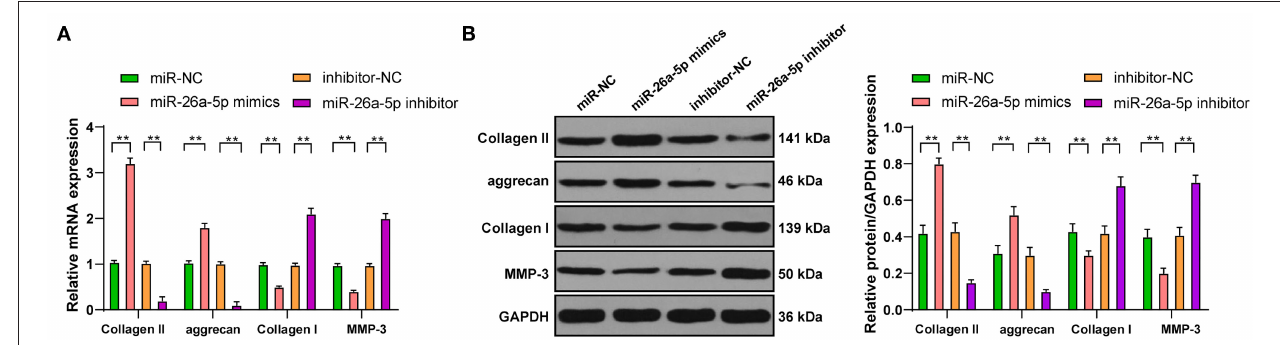
FIGURE 4 | Overexpression of miR-26a-5p can promote ECM synthesis in degenerative NPCs. In degenerative NPCs transfected with miR-26a-5p mimic/inhibitor, the mRNA, and protein levels of ECM-related genes were detected by (A) RT-qPCR and (B) Western blot. The cell experiment was repeated three times, and the data were expressed as mean ± standard deviation and analyzed using one-way, followed by Tukey’s multiple comparisons test. ** p < 0.01.